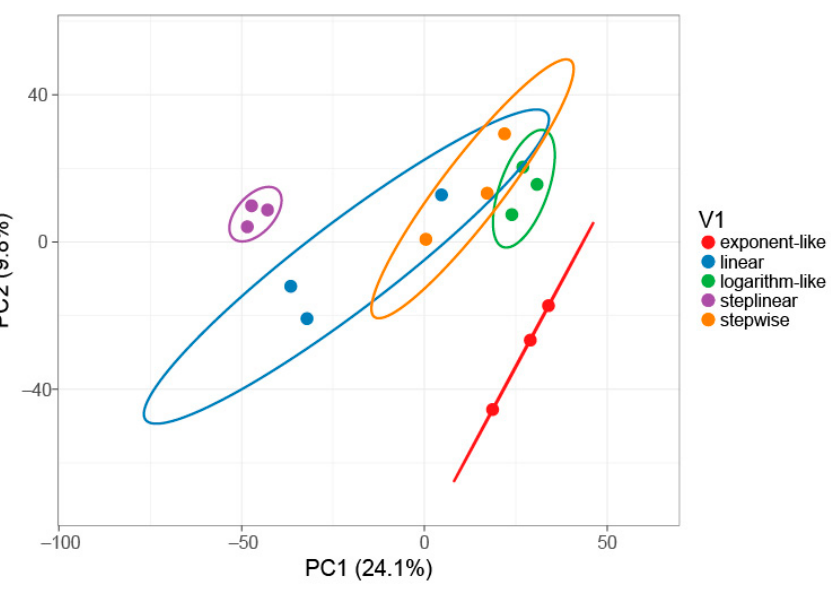
Figure 3. PCA plot of the five different gradient types based on all 4127 proteins identified across all five gradients. Prediction ellipses represent the 95% confidence interval. PCA analysis was performed using ClustVis tool [26]. The PCA was blinded to the unique spectral counts of all 4127 proteins identified across all five gradients using MSFragger (Table S2).